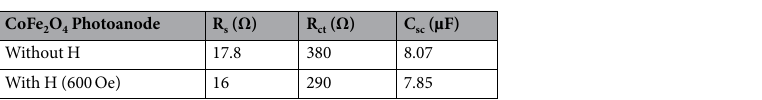
Table 1. Fitting parameters of the elements used in the equivalent circuit model calculated using Z-View